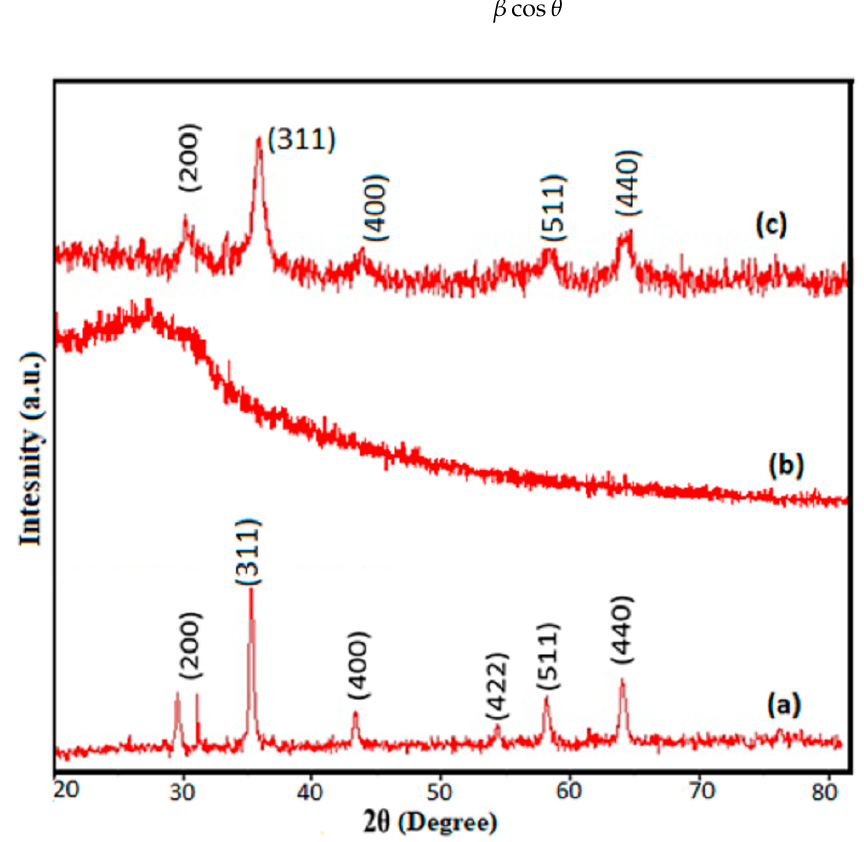
Figure 2. XRD Spectra of (a) α -Fe 2 O 3 (b) XG and (c) XGFO.